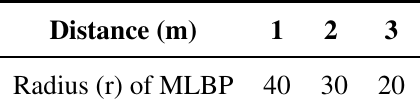
Figure 9. Four gestures used for the hand tracking evaluation: ( a ) circle; ( b ) triangle; ( c ) up to down and the reverse; ( d ) left to right and the reverse. Table 2. Radius values used for the hand tracking